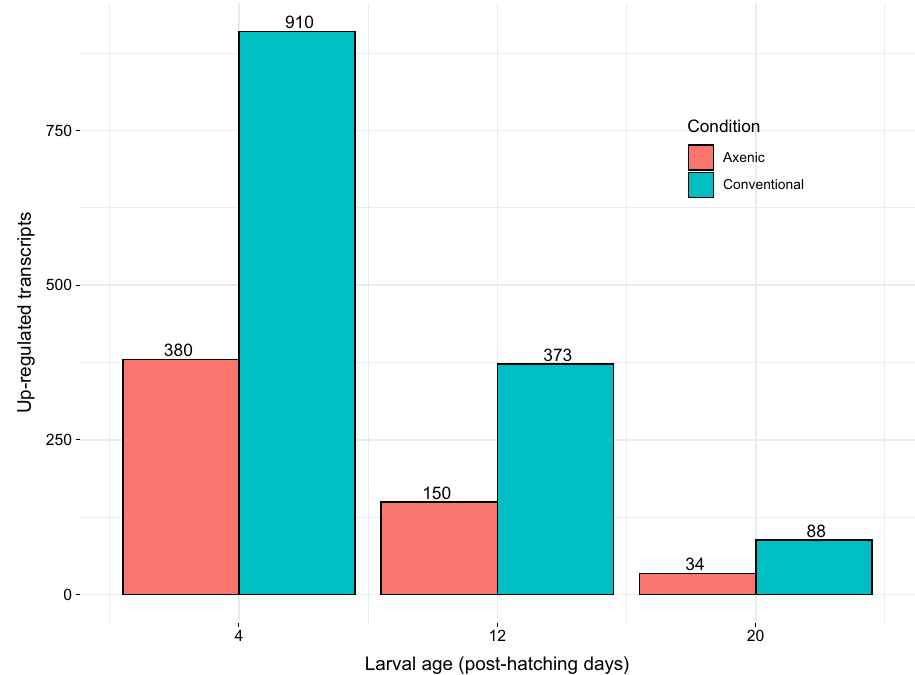
Figure 2. Differentially expressed transcripts upregulated for each condition. In red are the number of DETs upregulated for axenic and in blue for conventional larvae (N = 5 pools of 6 larvae/condition/time point) at the time points 4, 12 and 20 (day 1 =